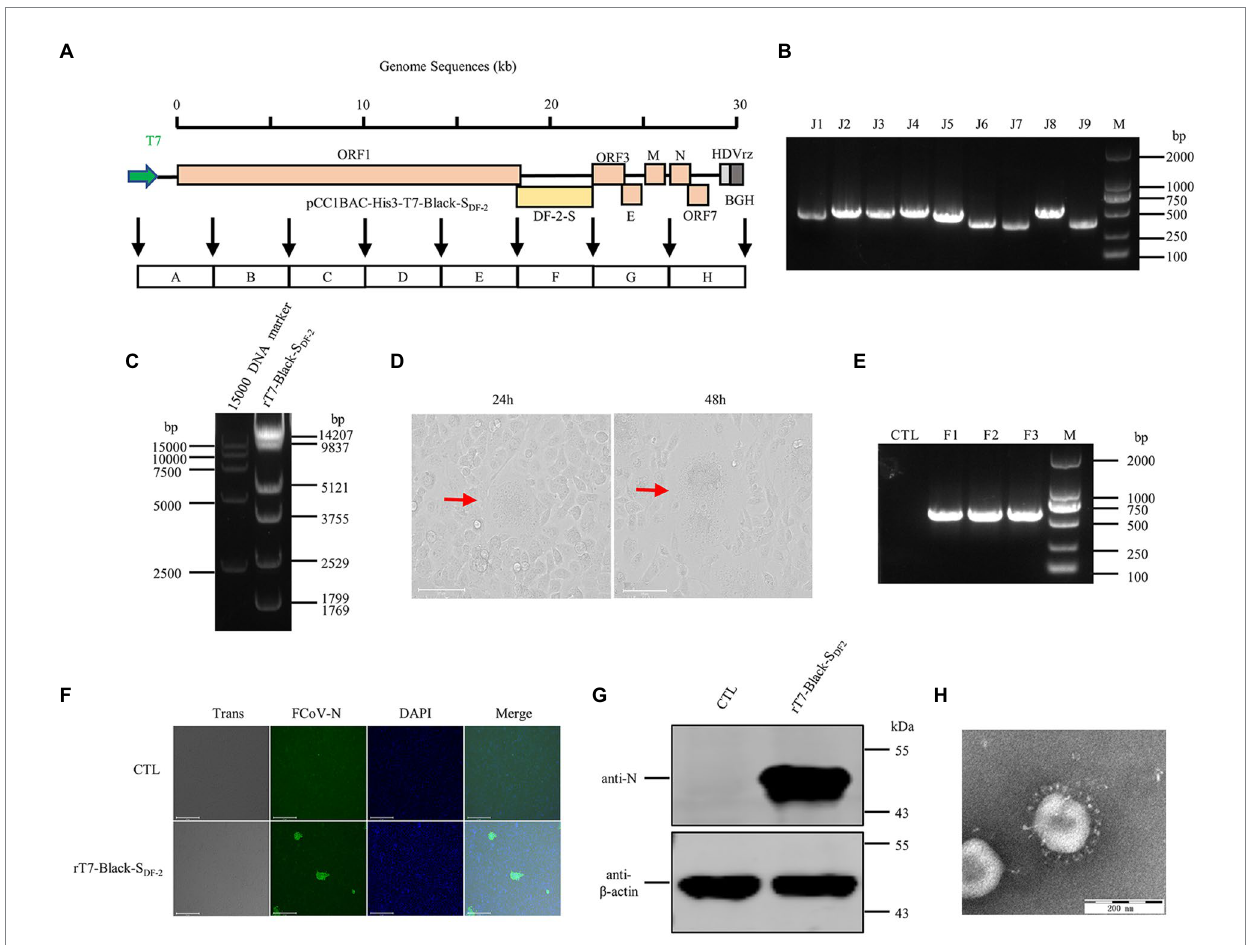
FIGURE 2 The recovery and identification of chimeric FIPV strain Black-SDF-2 driven by a T7 promoter. (A) Strategy diagram for the construction of pCC1BAC- His3-T7-Black-SDF-2. (B) Identification of fragment interfaces of the plasmids recovered from bacteria. (C) Enzyme digestion of pCC1BAC-His3-T7- Black-SDF-2 plasmid (NotI and NheI). (D) Significant cytopathic effects (CPE) were observed at 24 and 48 h after infection with CRFK cells. (E) PCR identification of the rescued recombinant virus. (F) and (G) rT7-Black-SDF-2 virus infected CRFK cells for 12 h was identified by IFA (Scale Bar, 275 μ m) and WB. (H) Electron microscopy examination of the purified